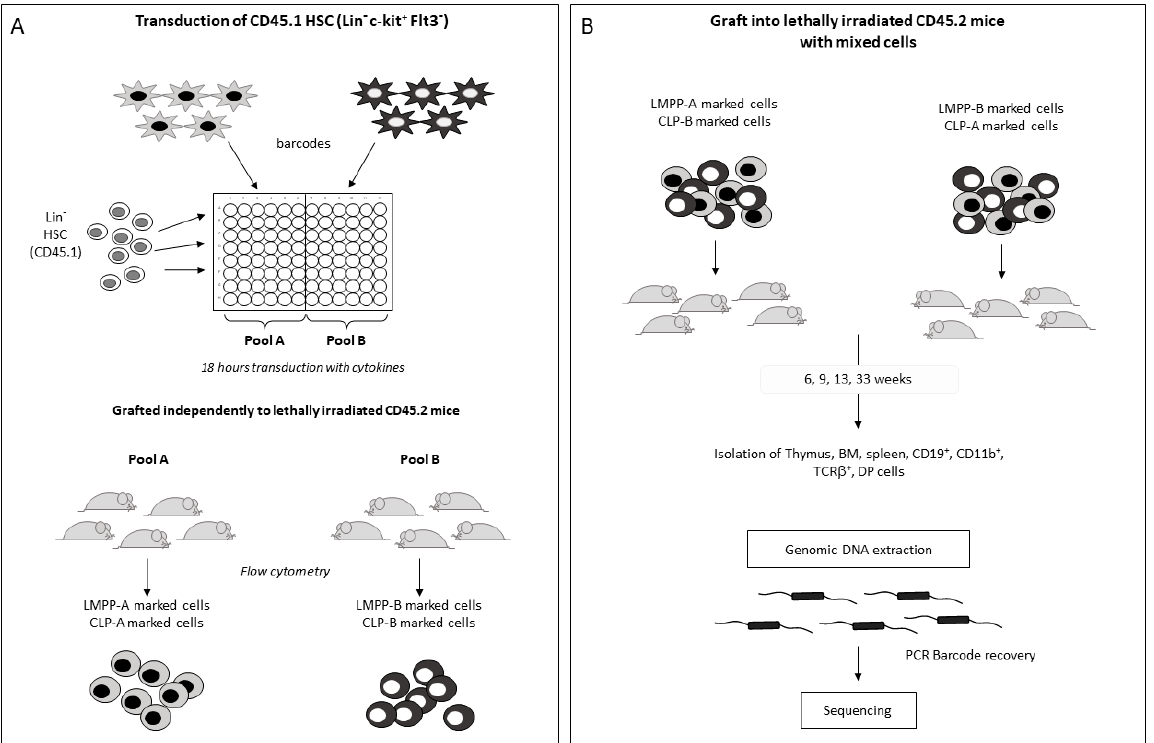
Figure 3. Strategy to obtain barcoded LMPP and CLP populations in vivo . ( A ) Lin − c-Kit + Flt3 − CD45.1 HSC were marked independently with 10 different BCs. From these, two pools of cells (pool A and pool B) were constituted. Each pool is a mix of cells containing 5 different BCs. Both pools were grafted into CD45.2 mice. BM cells of the transplanted mice were then prepared and sorted with specific markers to obtain barcoded LMPP and CLP. ( B ) To determine the fate of each progenitor, two groups were further constituted. Group 1 was composed of equal numbers (500 cells) of LMPP- barcoded with pool A + CLP-barcoded with pool B, and group 2 was constituted of LMPP-barcoded